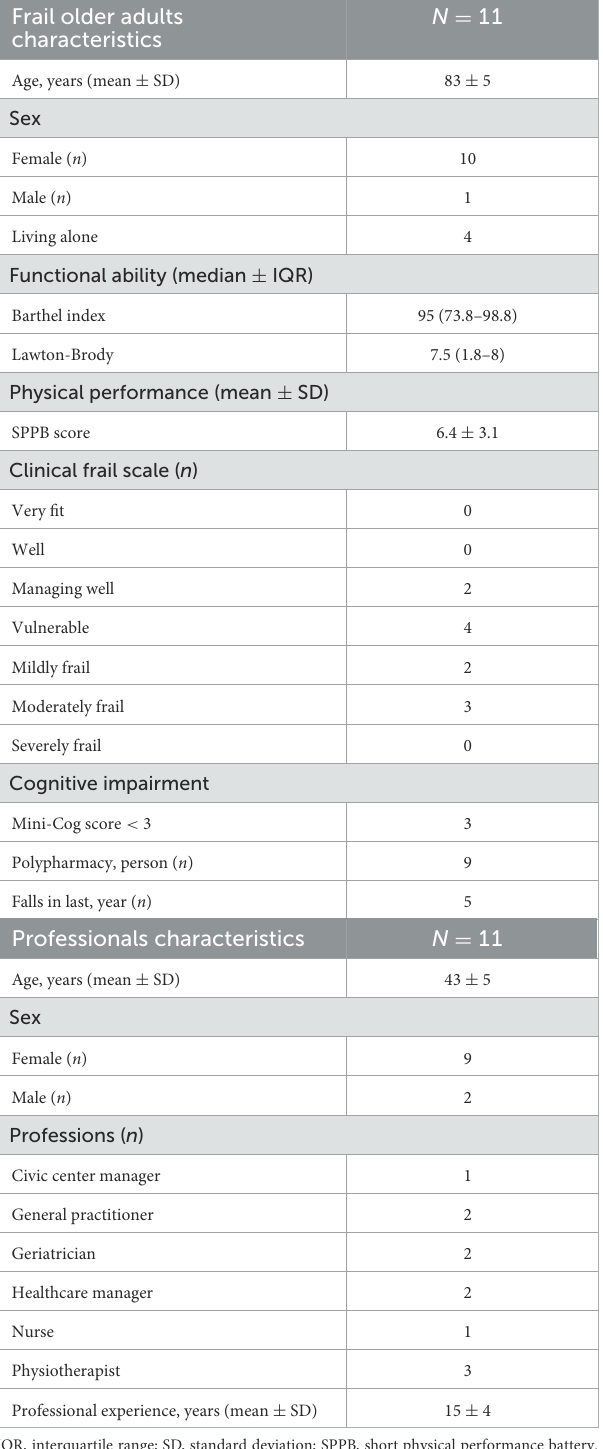
TABLE 2 Description of